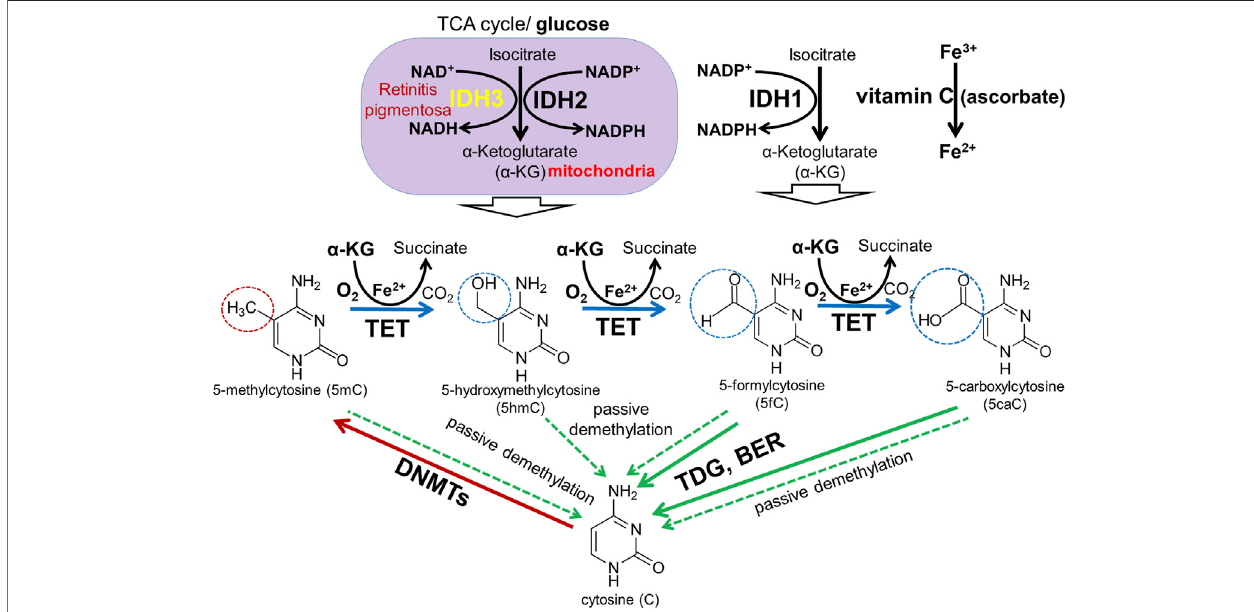
FIGURE 8 | DNA methylation and demethylation pathways: During development, patterns of methylated cytosines are established by the de novo methyltransferases Dnmt3a/Dnmt3b, and subsequently preserved through cell divisions by Dnmt1. The TET family promotes DNA demethylation by oxidizing 5mC to produce 5hmC, 5fC, and 5caC in DNA. Oxidized derivatives of 5mC inhibit Dnmt1, promoting passive DNA demethylation (dashed lines). 5fC and 5caC are directly excised bythymineDNAglycosylase (TDG) togenerateabasic sitestriggeringbaseexcisionrepair (BER) pathway activationfollowedbyreplacement oftheabasic sites with unmodi fi ed